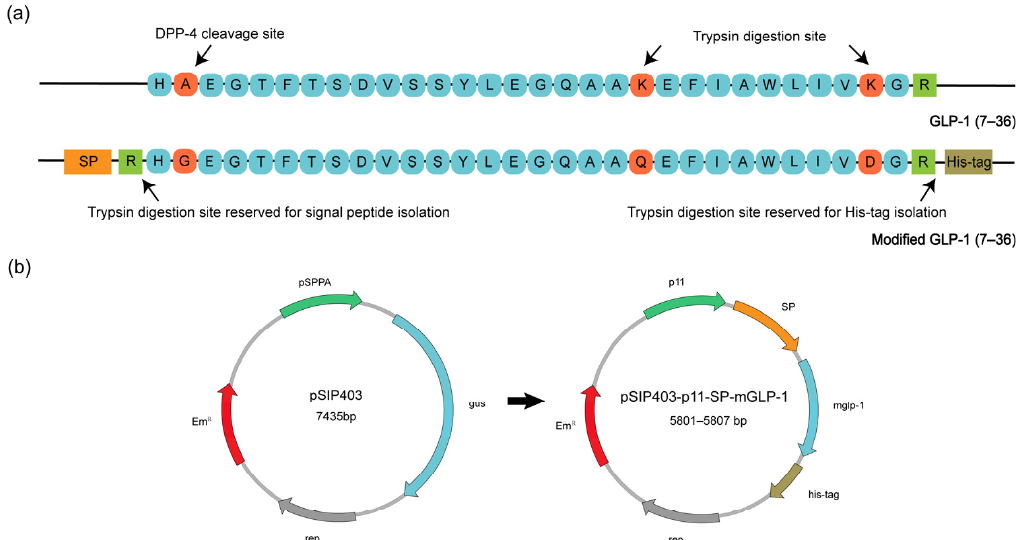
Figure 1. Schematic diagram of the modi fi cation of modi fi ed GLP-1 (mGLP-1) and plasmids. ( a ) Amino acid sequence comparison of native GLP-1 (7–36) and mGLP-1; ( b ) The schematic repre- sentation of the pSIP403 and constructed plasmid pSIP403-p11-SP-mGLP-1.